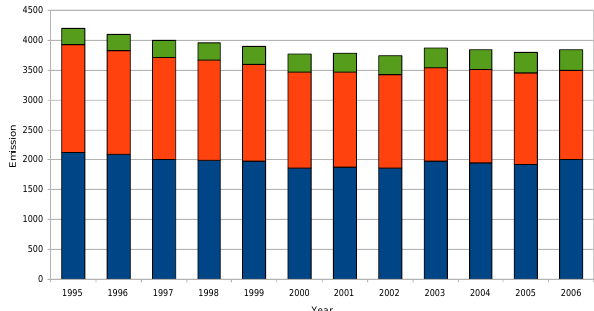
Fig. 4. Annual emissions of nitrogen oxides (NO 2 -N) and ammonia Fig. 4 . Annual emissions of nitrogen oxides (NO2-N) and ammonia (NH3-N) from all (NH3-N) from all HELCOM Contracting Parties and annual nitro- HELCOM Contracting Parties and annual nitrogen oxides emissions from the international gen oxides emissions from the international ship traffic on the Baltic ship traffic on the Baltic Sea (BAS-N) in the period 1995-2006. Units: Gg N per year. Sea (BAS-N) in the period 1995–2006. Units: GgN per